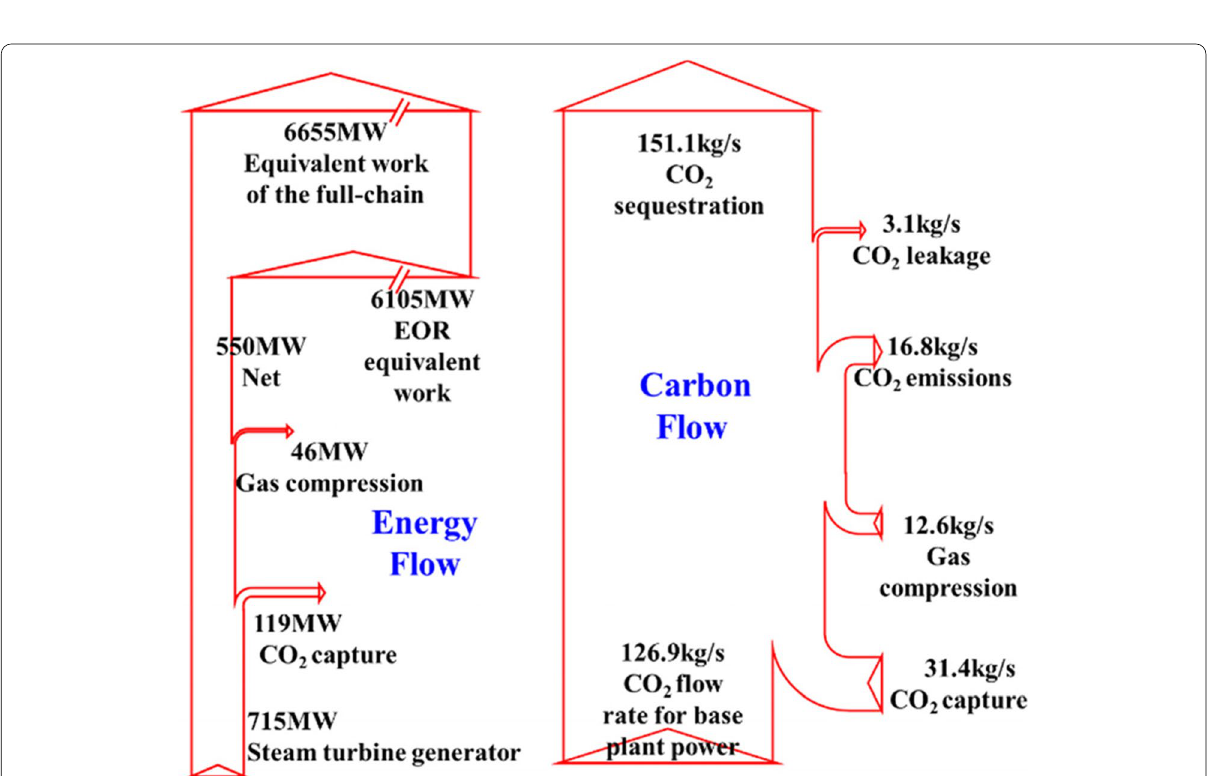
Fig. 8 Diagram showing the energy flow and carbon flow of the full‑chain